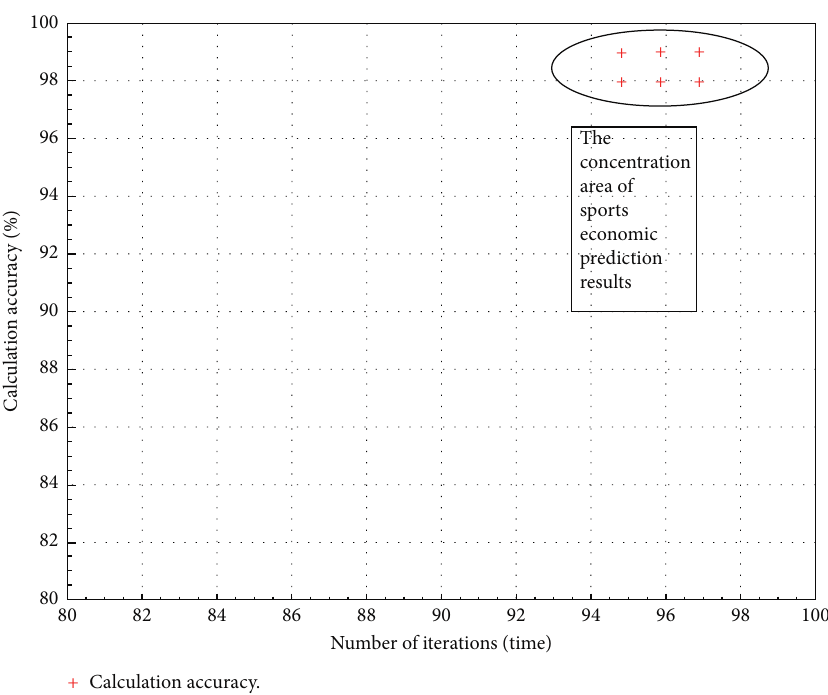
Figure 3: The concentration area of the sports economy calculation results.